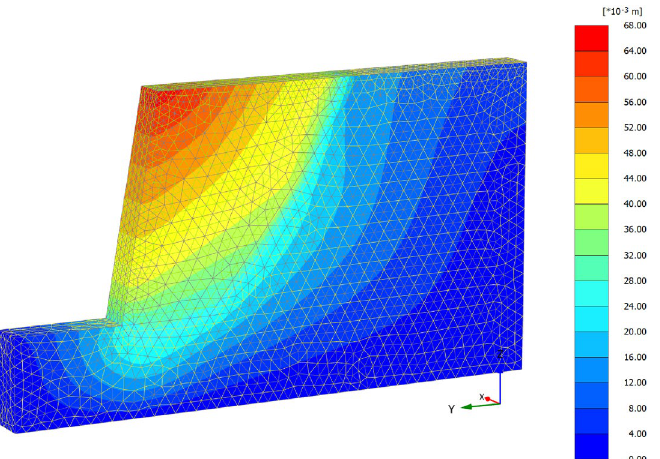
Figure 5. Deformation nephogram of unsupported slope.